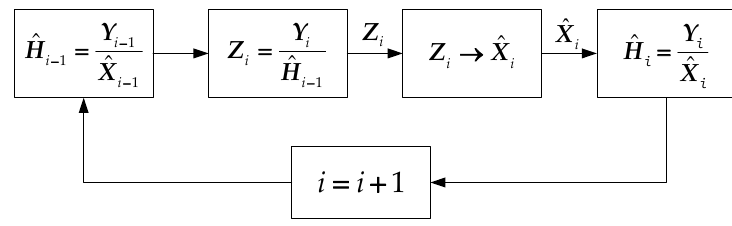
Figure 3. Decision feedback (DF) channel estimation method in CP-OFDM system.